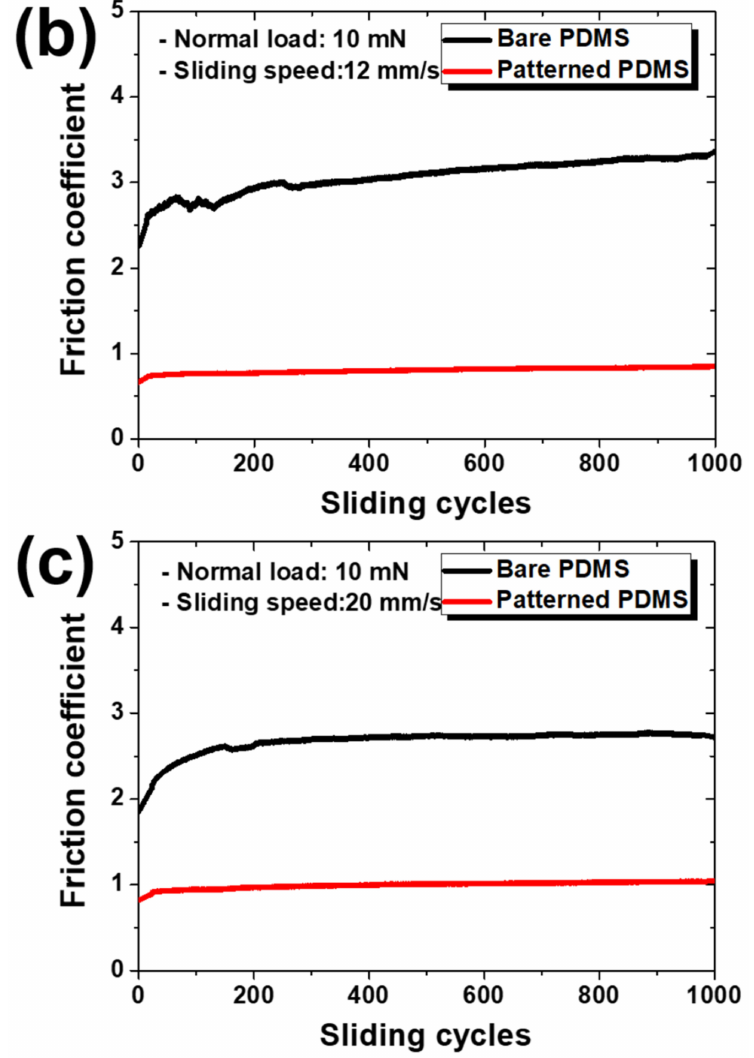
Figure 3. Variations in friction coefficients according to sliding cycles at sliding speeds of ( a ) 4 mm/s, ( b ) 12 mm/s, and ( c ) 20 mm/s under a normal load of 10 mN for bare PDMS and micro/nanopatterned